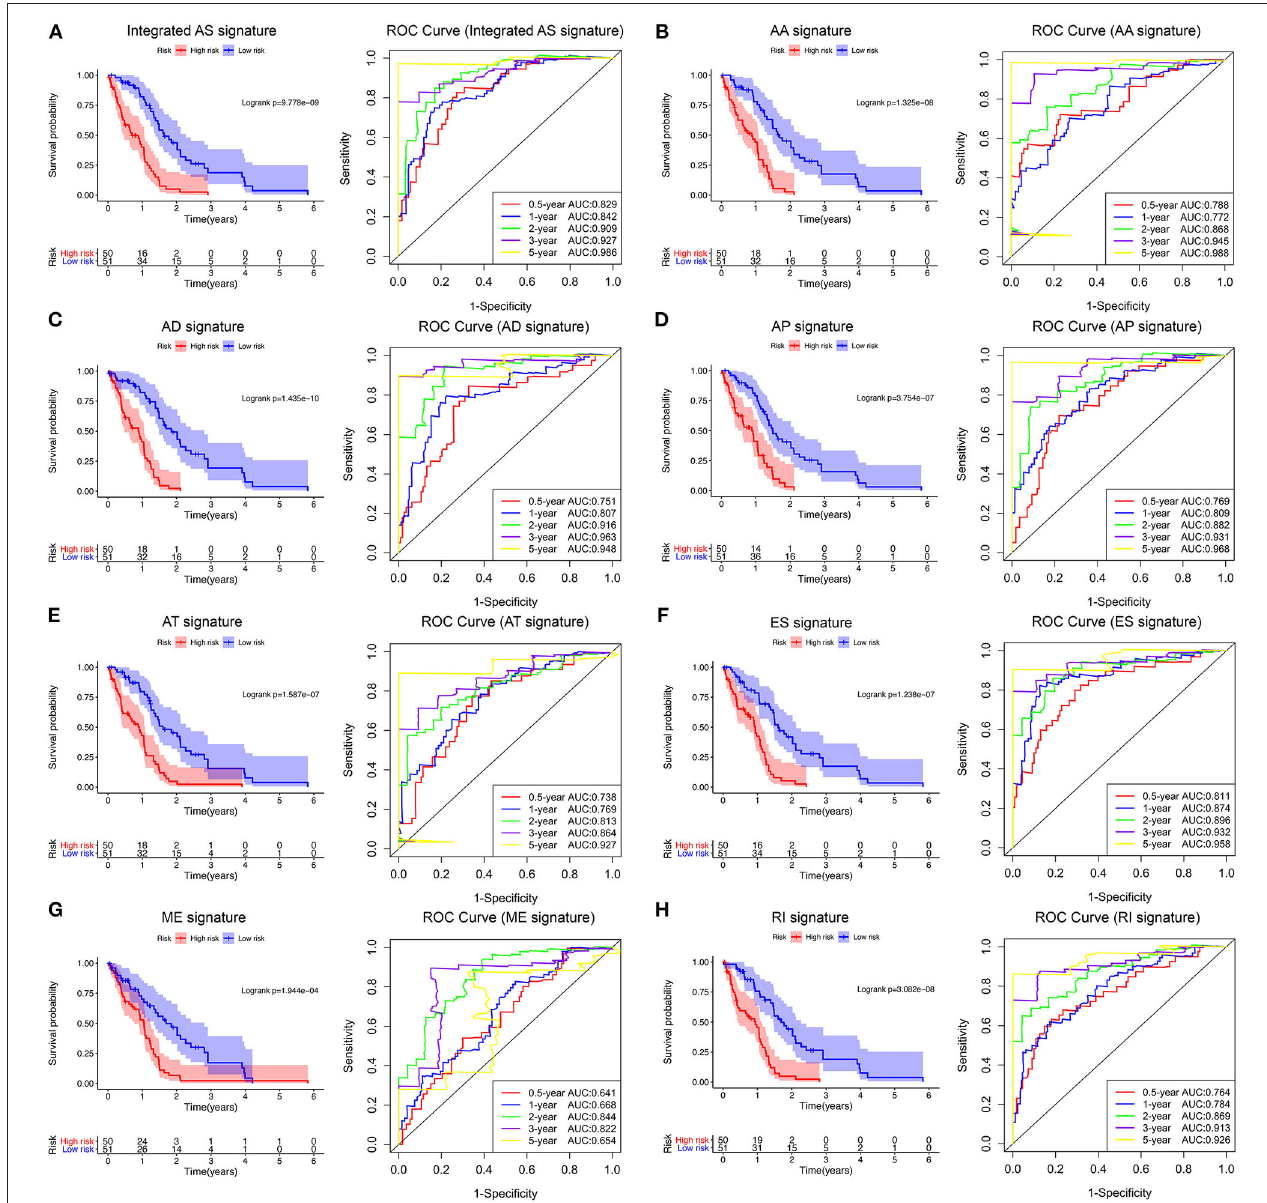
FIGURE 5 | Survival analysis and prognostic performance of the integrated AS signature and the 7 type-specific AS signatures of GBM patients in the TCGA training set. Left panel (A–H) K-M survival curve of the risk score for the OS of GBM patients. The high-risk group had significantly poorer OS rates than the low-risk group. Right panel (A–H) The prognostic performance of the AS-based signature, demonstrated by the time-dependent ROC curves for predicting 0.5-, 1-, 2-, 3-, and 5-year OS in GBM